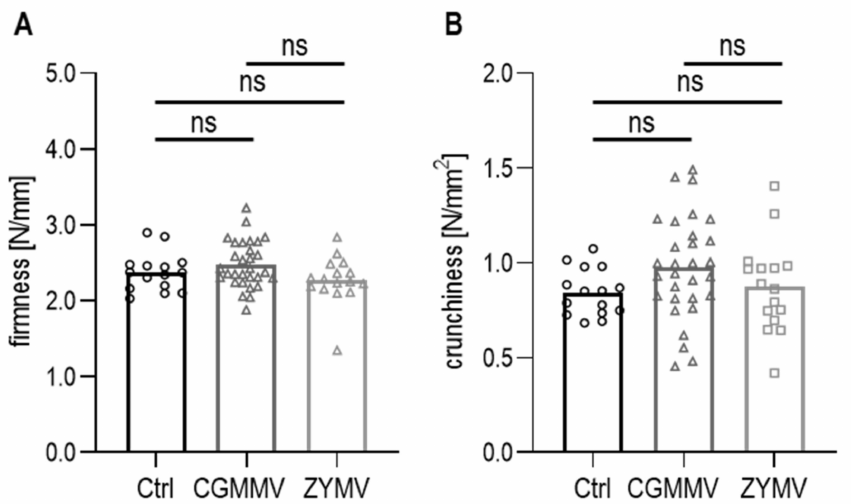
Figure 4. Comparison of the texture of virus-infected and non-infected C. sativus fruits shown by firmness (N/mm) ( A ) and crunchiness (N/mm 2 ) ( B ) of freshly harvested cucumbers. There are no significant differences between the control fruits (Ctrl, n = 15), CGMMV-infected (n = 30) and ZYMV-infected (n = 15) cucumbers. ANOVA was performed with ns p >